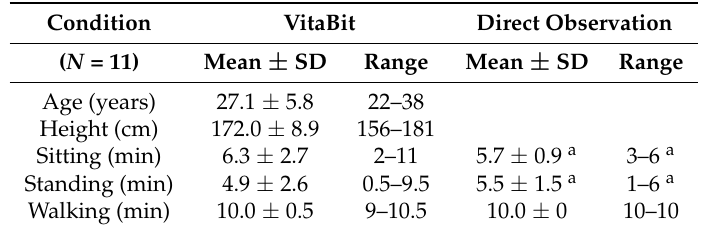
Table 2. Laboratory: Description of population and activity distributions.